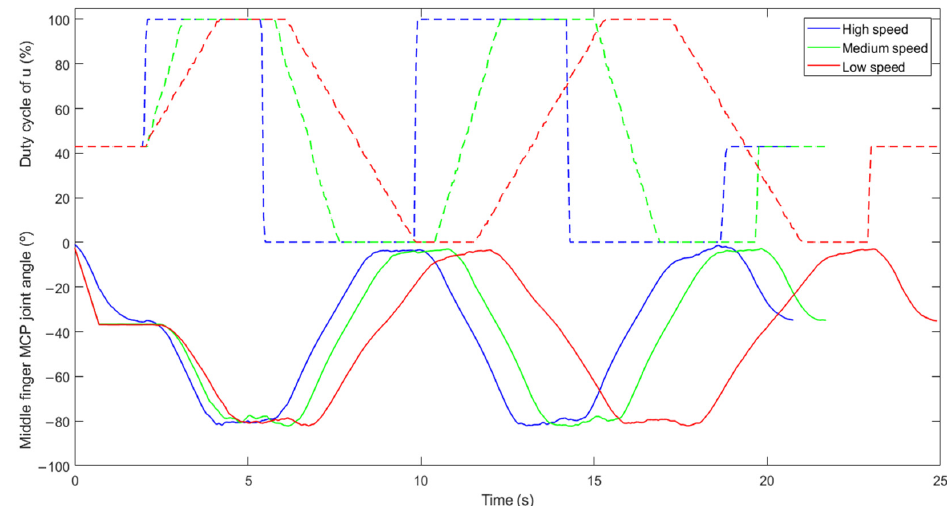
Figure 3. Recorded data of the MCP joint angle of the middle finger (full line) and duty cycle of the applied control signal u (dashed line) for different speeds (high, medium and low) when performing a flexion and extension of the five hand fingers simultaneously (2 repetitions and 2 s pause between closing–opening movement).